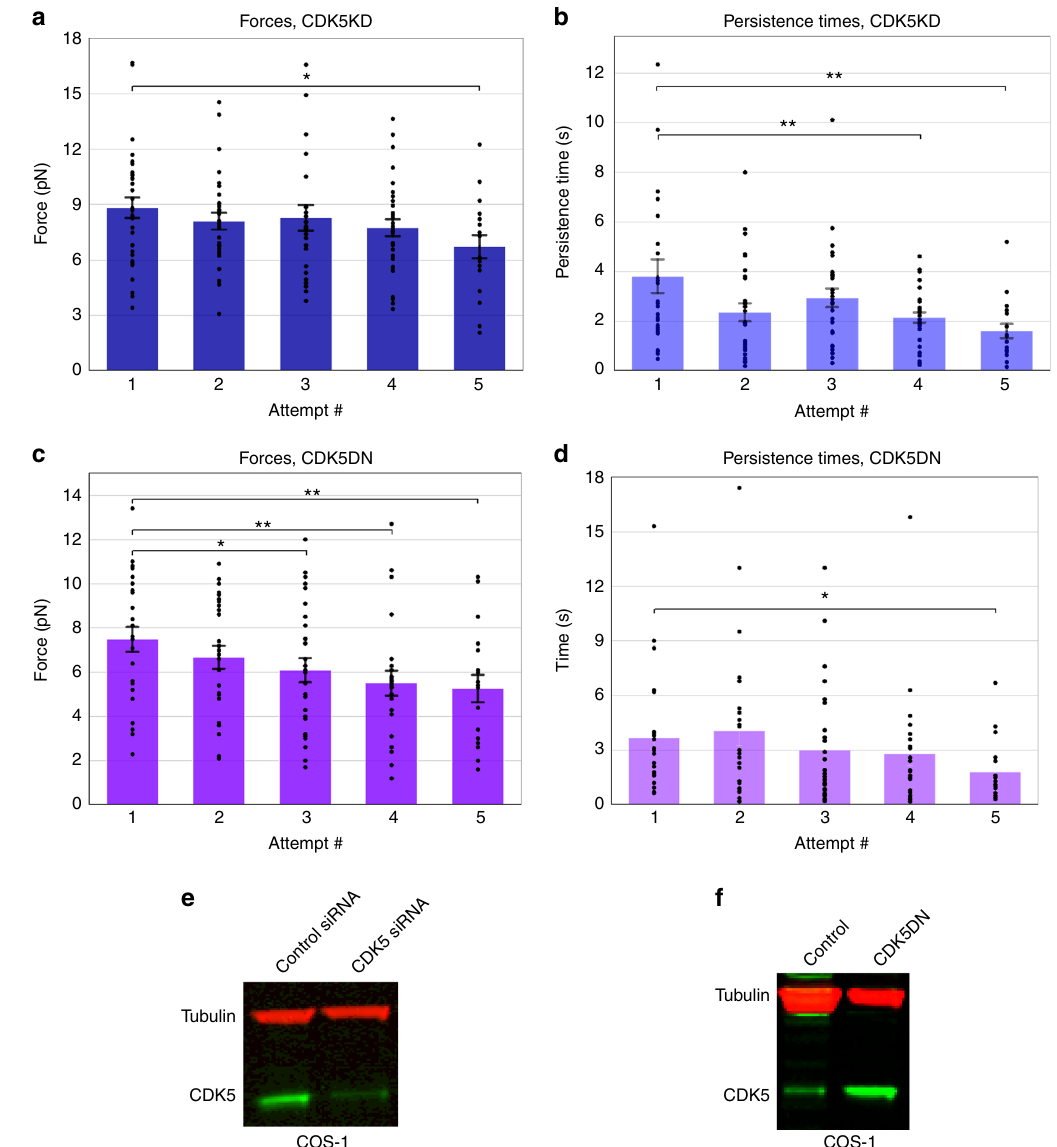
Fig. 2 CDK5 is essential for dynein force adaptation in COS-1 cells. Average peak forces for minus-end moving LDs decrease at successive attempts in CDK5 knockdown background ( a ) and CDK5dn overexpression background ( c ). Average persistence times for dynein-driven LDs show a signi fi cant decrease in CDK5 knockdown background ( b ) and CDK5dn overexpression background ( d ). CDK5 knockdown was >90% effective ( e ), and CDK5dn overexpression was successful (over 15× increase in the expression of control) ( f ). Quanti fi ed data represent the mean ± s.e.m. of n = 5